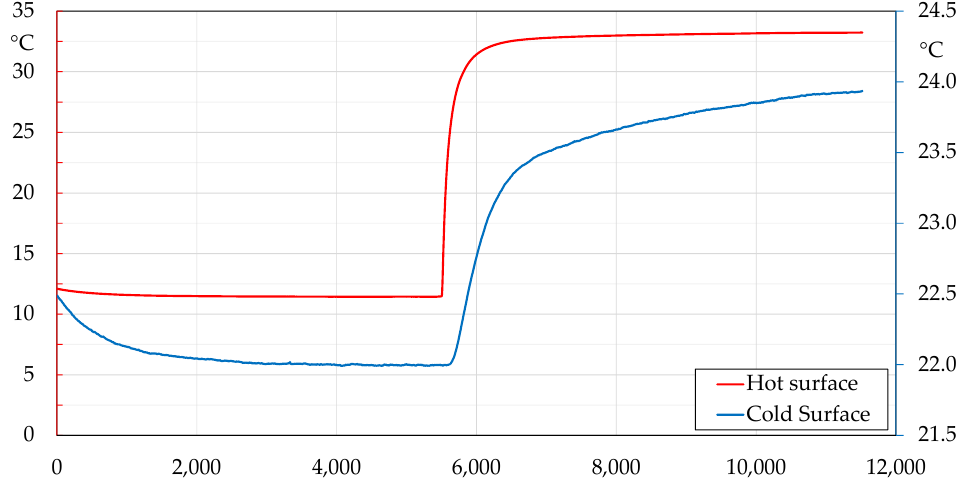
Figure 24. Trends of the sample surface temperatures detected in the climatic chamber by subjecting the external side to a temperature difference of 25 °C, applied instantaneously.